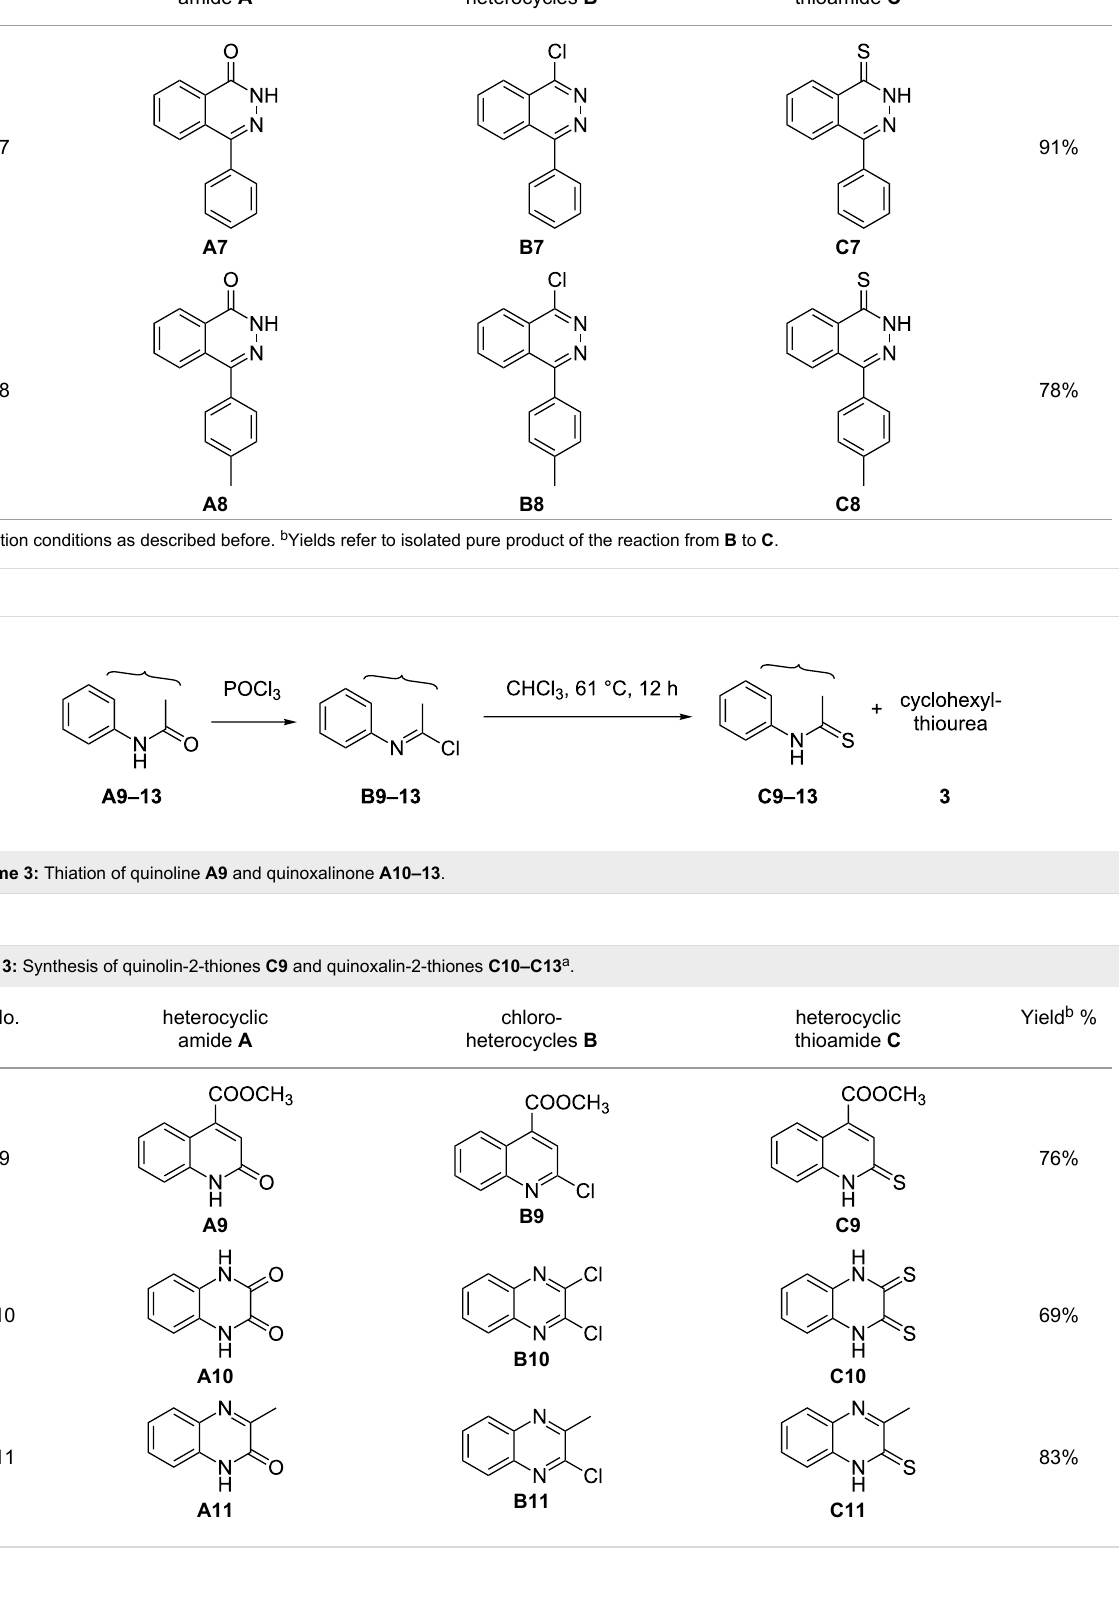
Table 2: Synthesis of phthalizin-1-thiones C7 and C8 a . No.